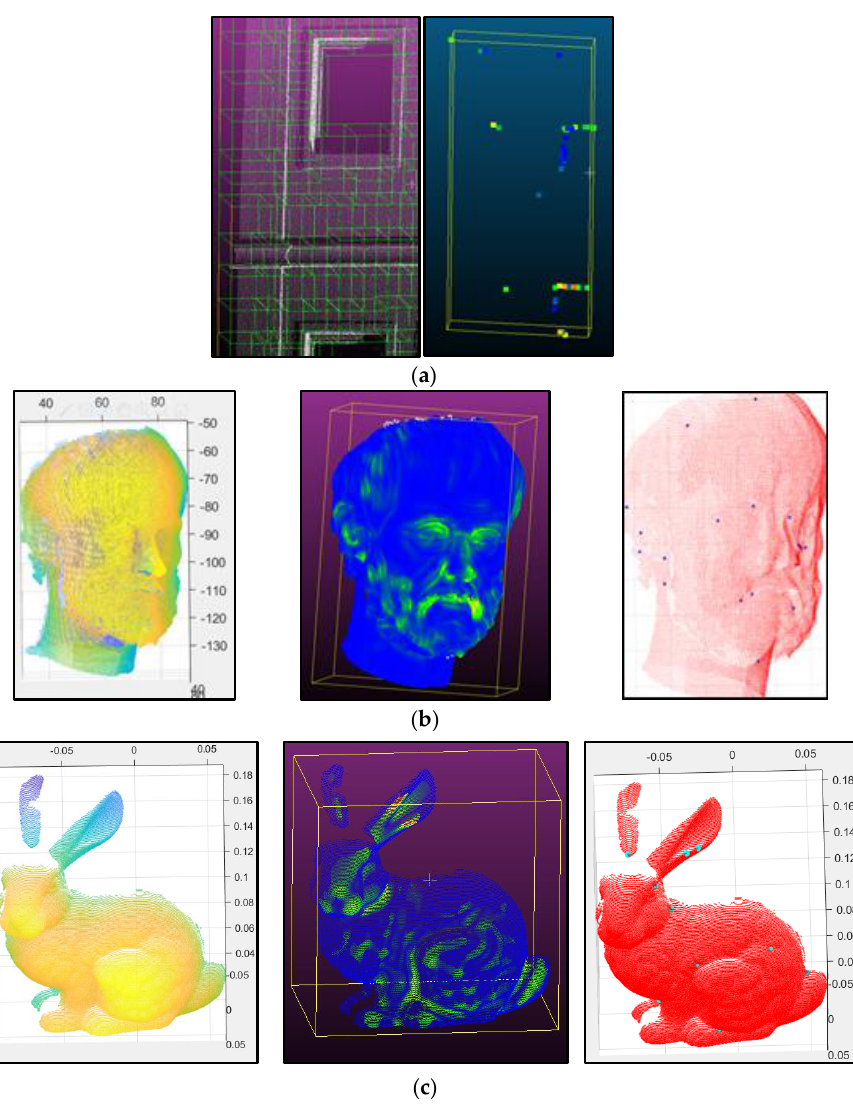
Figure 12. The fully automatic keypoint detection with the proposed algorithm: ( a ) for the building facade with voxels, ( b ) for the Aristotle sculpture and ( c ) for the Stanford bunny sculpture with color.